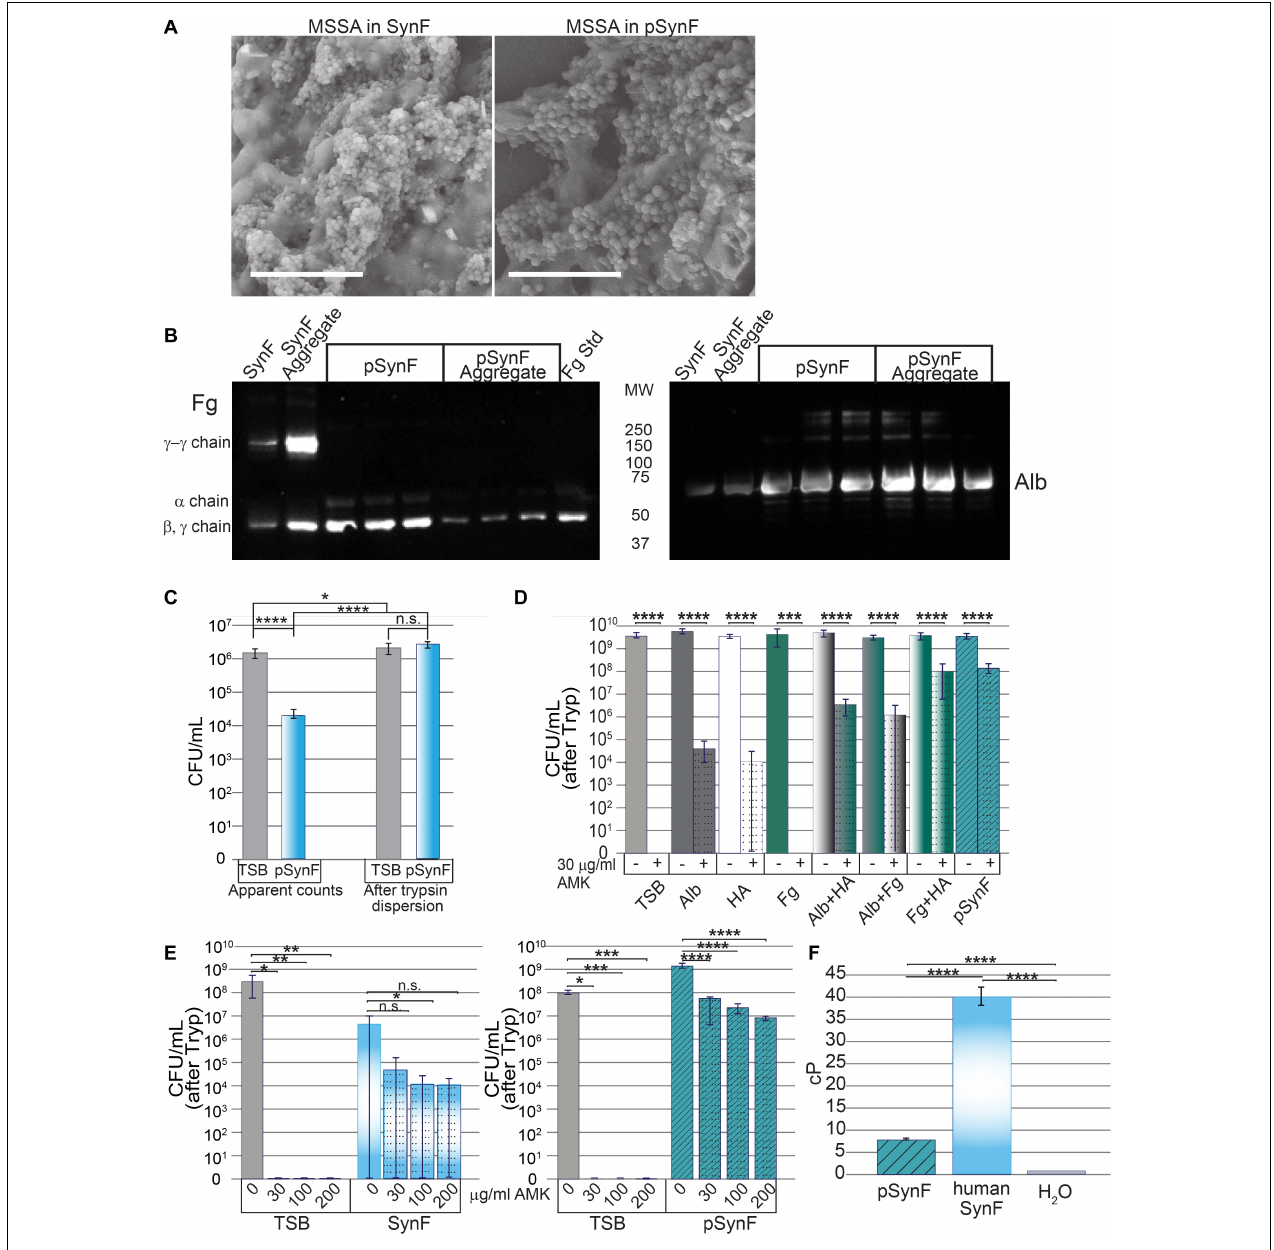
FIGURE 4 | Effects of pseudo synovial fluid (pSynF) on methicillin-susceptible Staphylococcus aureus (MSSA). (A) Comparison of MSSA aggregates in human synovial fluid (SynF) vs. pSynF using SEM. Magnification: scale bar = 15 µ m. (B) Fibrinogen (Fg) (left) and albumin (Alb) (right) content of pSynF and pSynF aggregates compared to aggregates formed in synovial fluid by Western blotting. (C) Graphs showing CFU/ml in Trypticase Soy Broth (TSB) and pSynF before trypsin dispersion vs. CFU/ml after trypsin dispersion [(“after Tryp” in subsequent graphs) n = 12 for each condition]. (D) Effects of amikacin (AMK) on fluids containing protein/proteoglycan concentrations found in pSynF. Controls are TSB alone and complete pSynF ( n = 8–9 for each condition). All components were dissolved in TSB. (E) Dose response of MSSA to AMK in TSB vs. synovial fluid (left; n = 9/condition) and of TSB vs. pSynF (right; n = 12/condition). (F) Viscosity of pSynF compared to that of synovial fluid and H 2 O using a ball velocity method ( n = 10/condition). Values graphed are means ± SD. Viscosity is expressed as centiPoise (cP). In panels (A–F) , * p < 0.05; ** p < 0.01; *** p < 0.001; **** p <